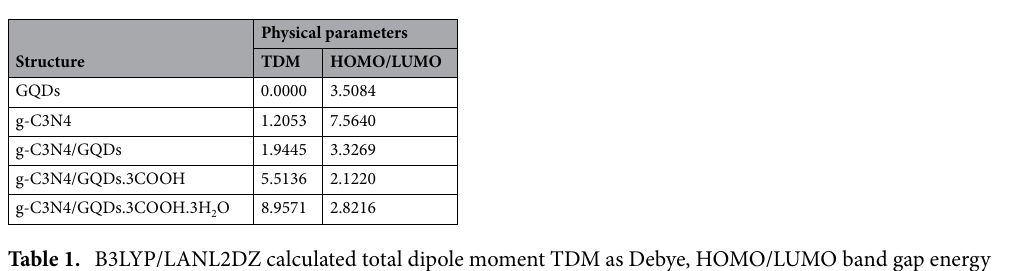
Physical parameters